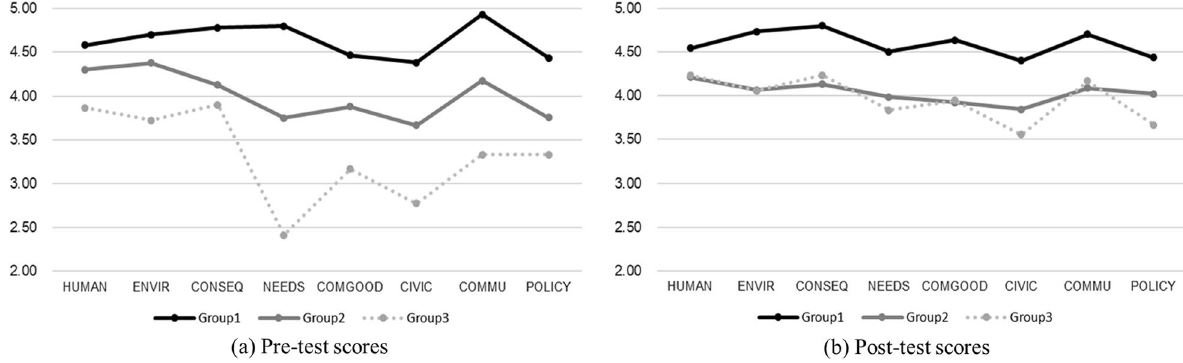
Fig. 2 VSRoSE scores using a three‑cluster model